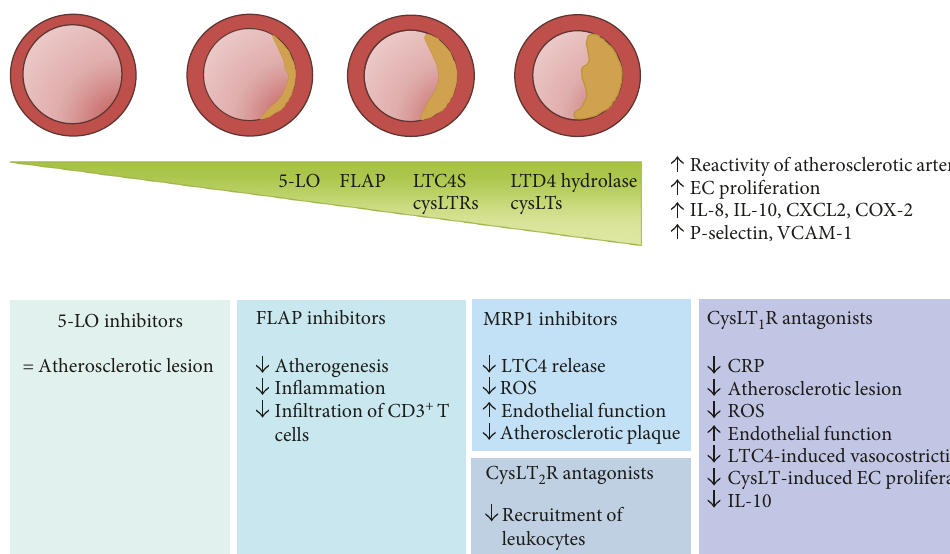
Figure 2: Involvement of the 5-LO pathway in the pathogenesis and progression of atherosclerosis and major e ff ects of CysLT modi fi ers in humans and in experimental